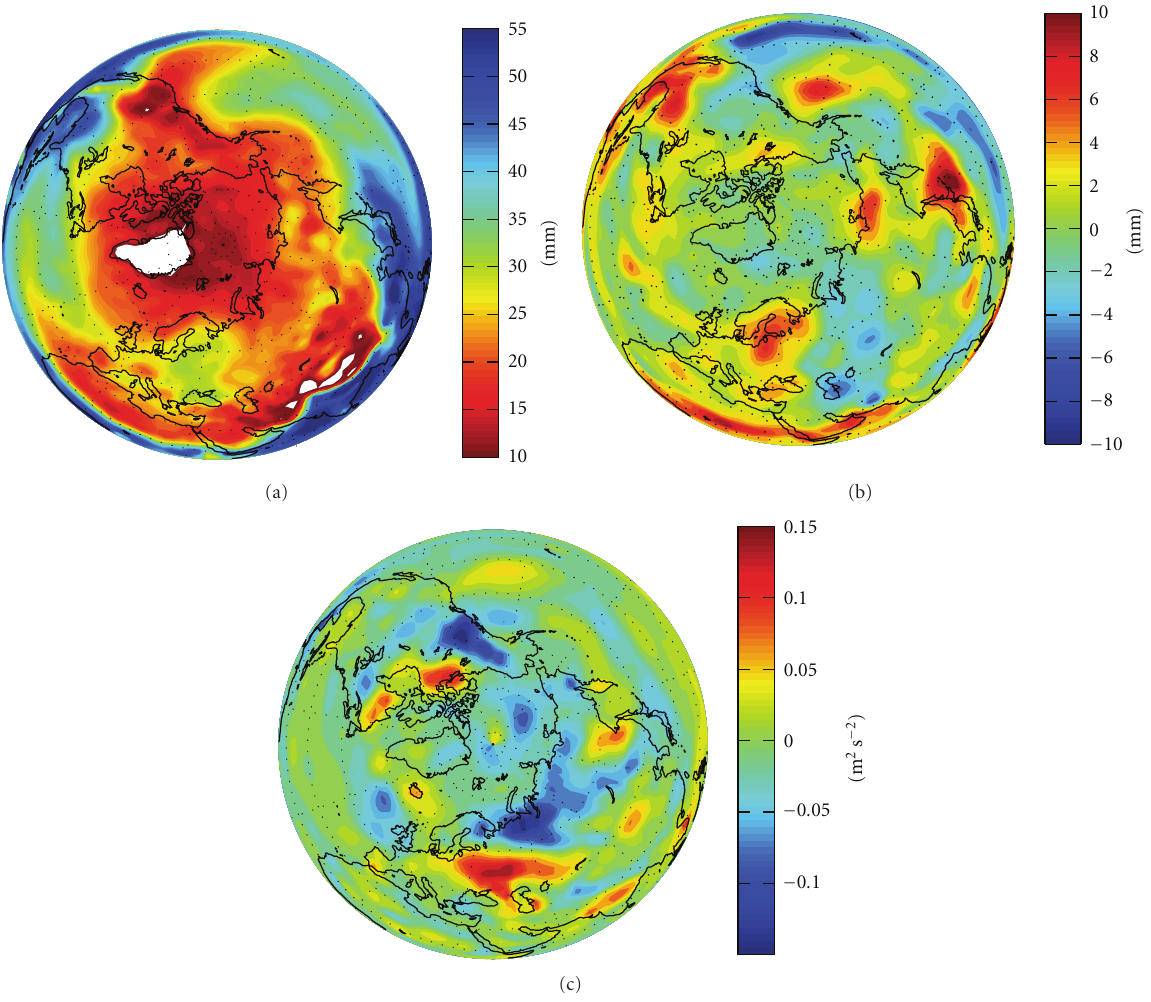
Figure 2: The Northern Hemisphere (a) precipitable water (mm), (b) precipitable water anomalies (mm), and (c) zonal momentum flux (m 2 s − 2 ) anomaly for July 2010, the climatological reference period is 1981–2010. In (b) and (c) positive (negative) numbers indicate more (less) moisture or zonal momentum flux than the mean and are represented by warm (cool) colors.